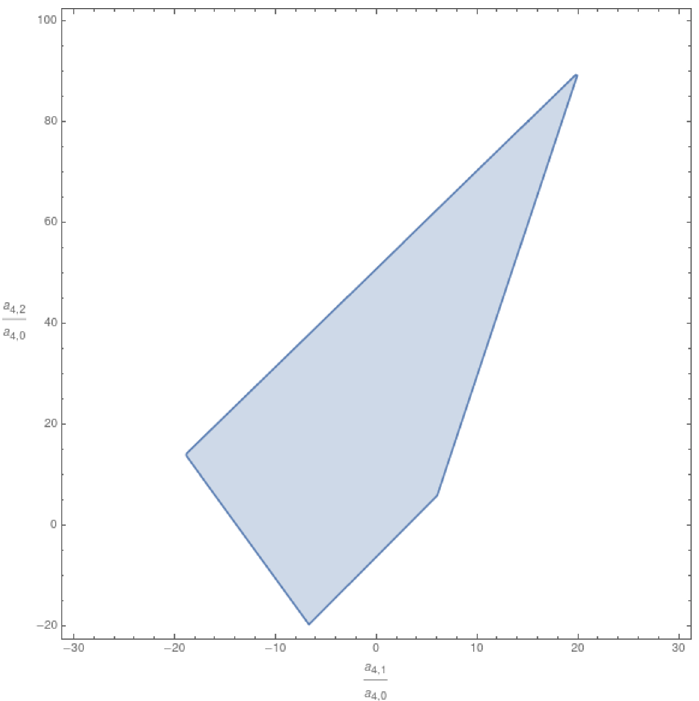
Figure 17 . The intersection of the P 4 polytope defined by the boundaries in eq. (9.19) with X sym .